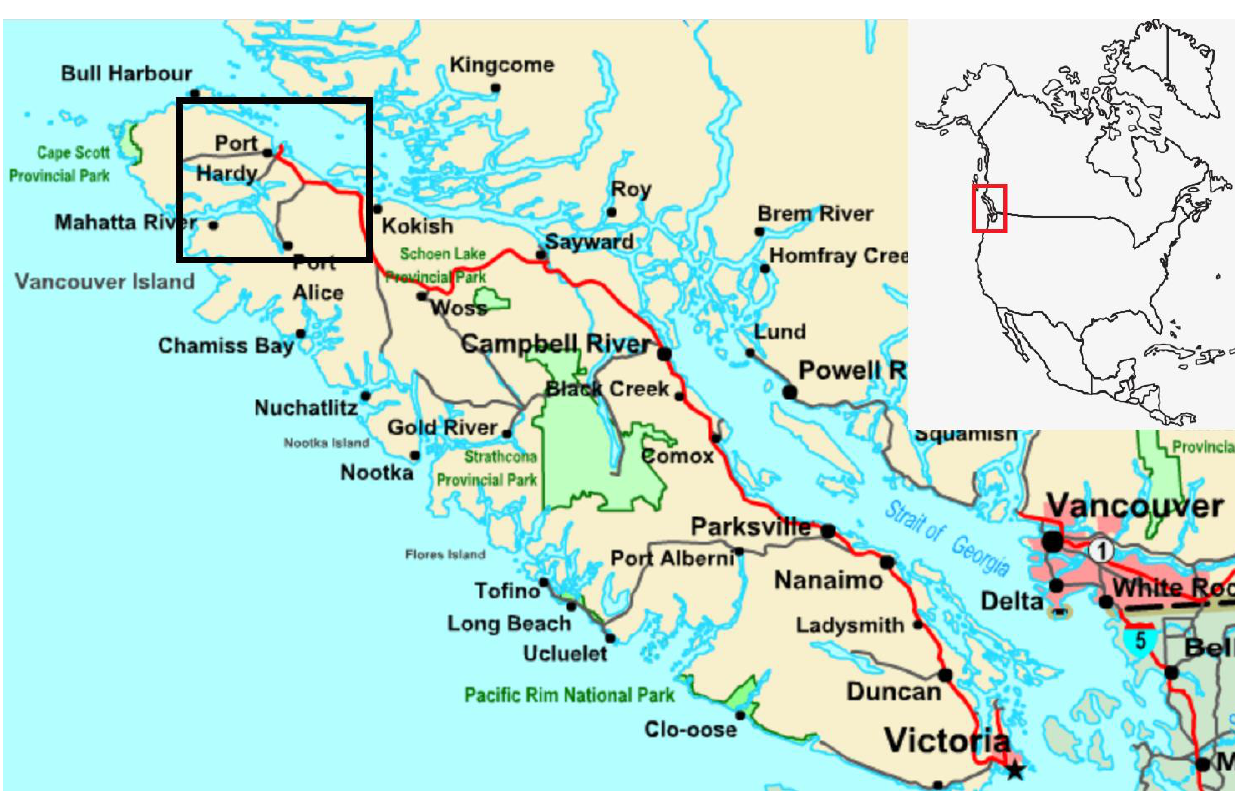
Figure 2. Region of study in northern Vancouver Island (black rectangle), and its location in the western coast of Canada.